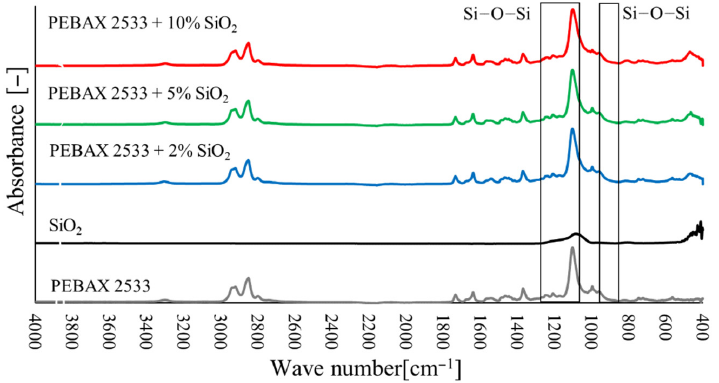
Figure 11. FTIR analysis of membranes containing SiO 2 in different concentrations.